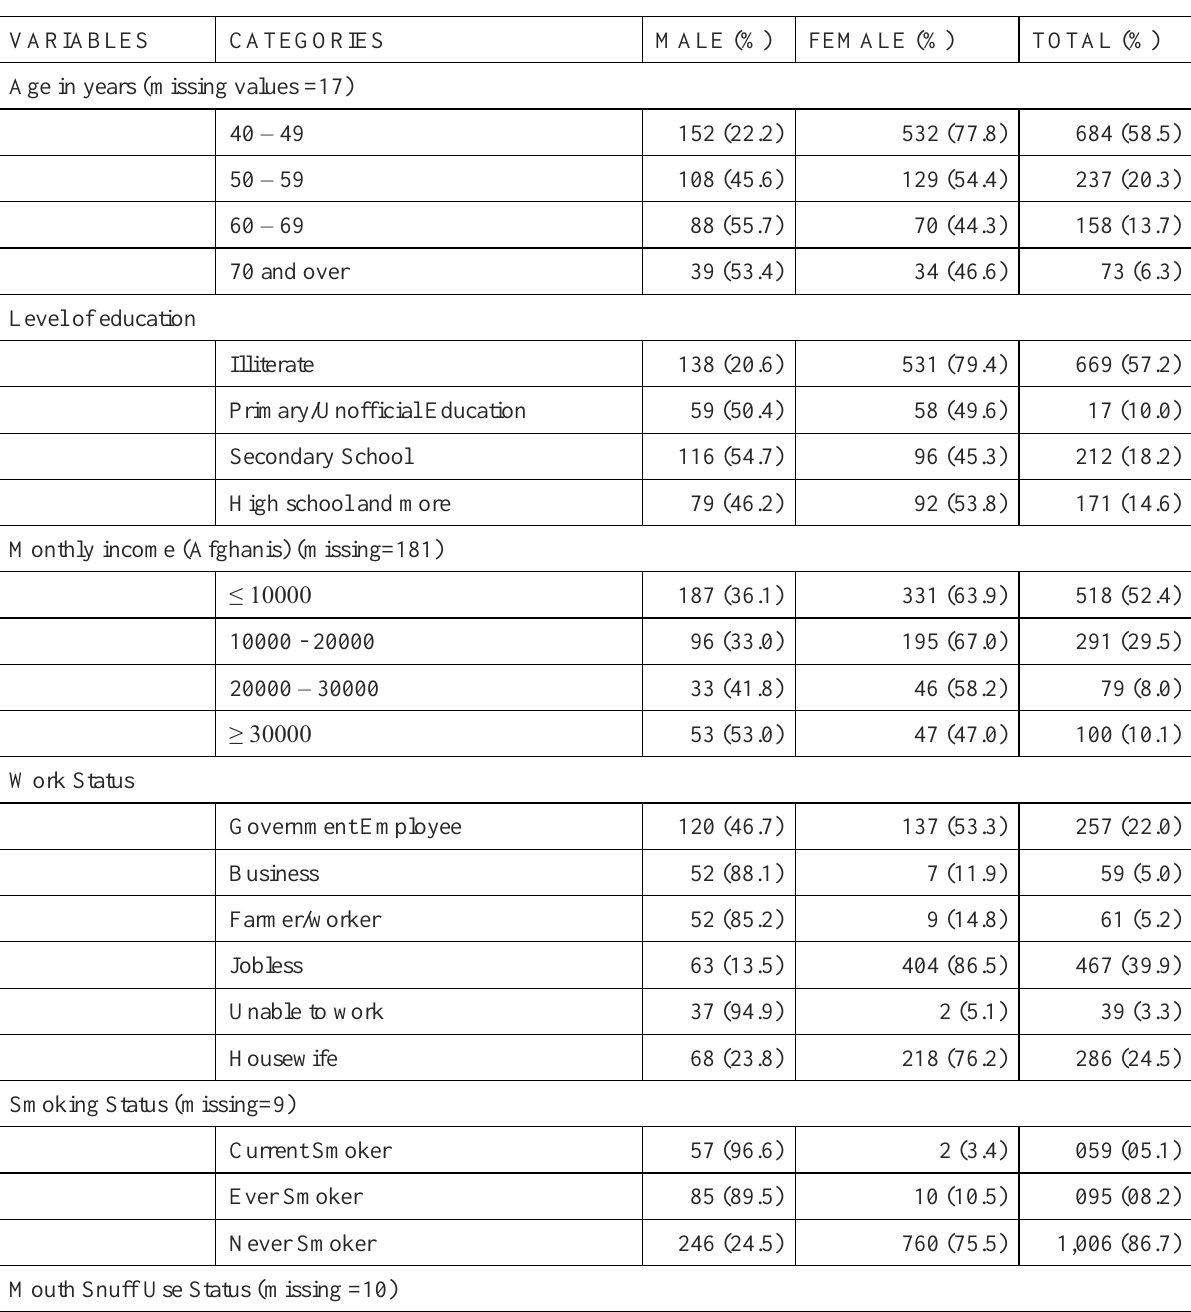
Table 1: Frequency distribution of the background characteristics of study participants